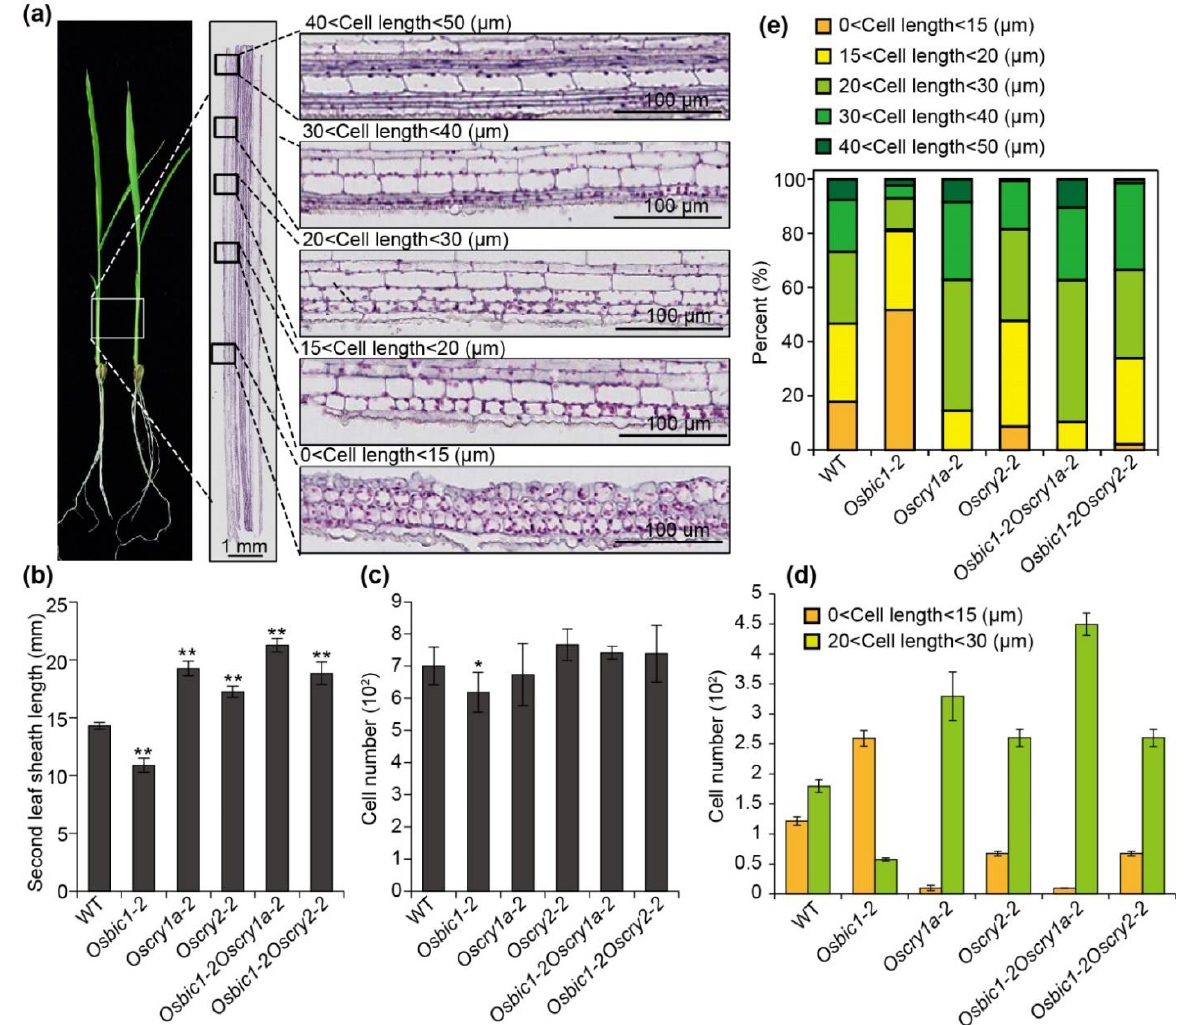
Figure 3. OsBIC1 and OsCRYs controlled the cell elongation in response to blue light. ( a ) Two seedlings of WT to show the position of the second leaf sheath (( a ) left panel). The epidermal cells were divided into five groups according to the cell length: 0–15 µ m, 15–20 µ m, 20–30 µ m, 30–40 µ m, and 40–50 µ m (( a ) middle panel and right panel). ( b – d ) Comparisons of the second leaf sheath length ( b ), cell number of the outermost epidermal cells ( c ), and cell numbers of the outermost epidermal cells of 0–15 µ m and 20–30 µ m in length ( d ) analysis between WT and each indicated mutants. ( e ) Comparison of the percentage of cell number in different groups between WT and each indicated mutants. Mean values ± s.d. ( n = 10) are shown. Comparisons were performed by Student’s t -tests (* p < 0.05, ** p <